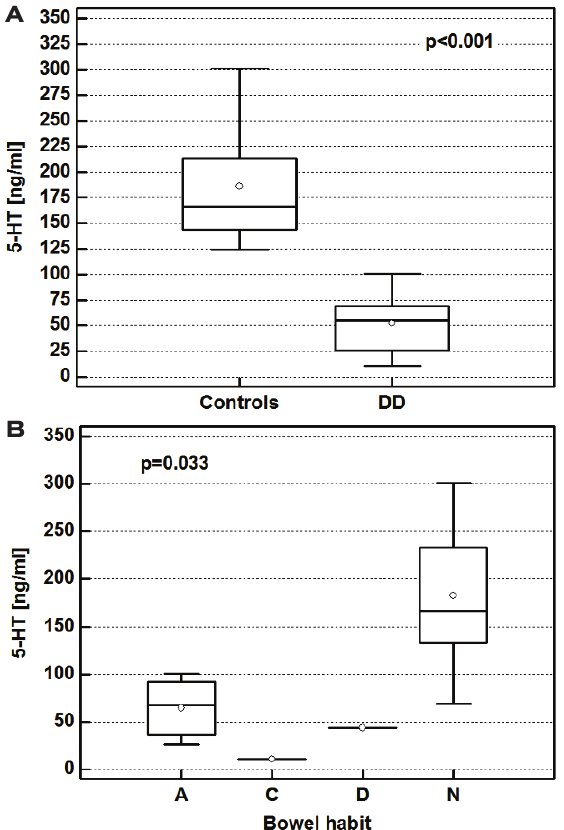
Figure 1. Fasting serum serotonin levels in study participants stratified by diverticular disease (DD) presence (A) or bowel habit (B). Boxes represents 25 and 75 percentile; bars inside the boxes – medians; open circles – means; whiskers – 95% CI.